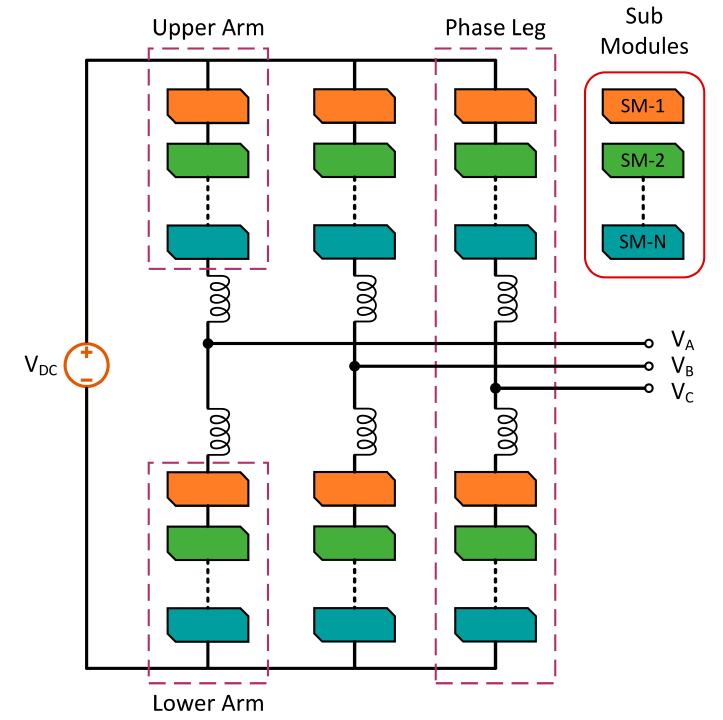
Figure 7. Topology of modular multilevel